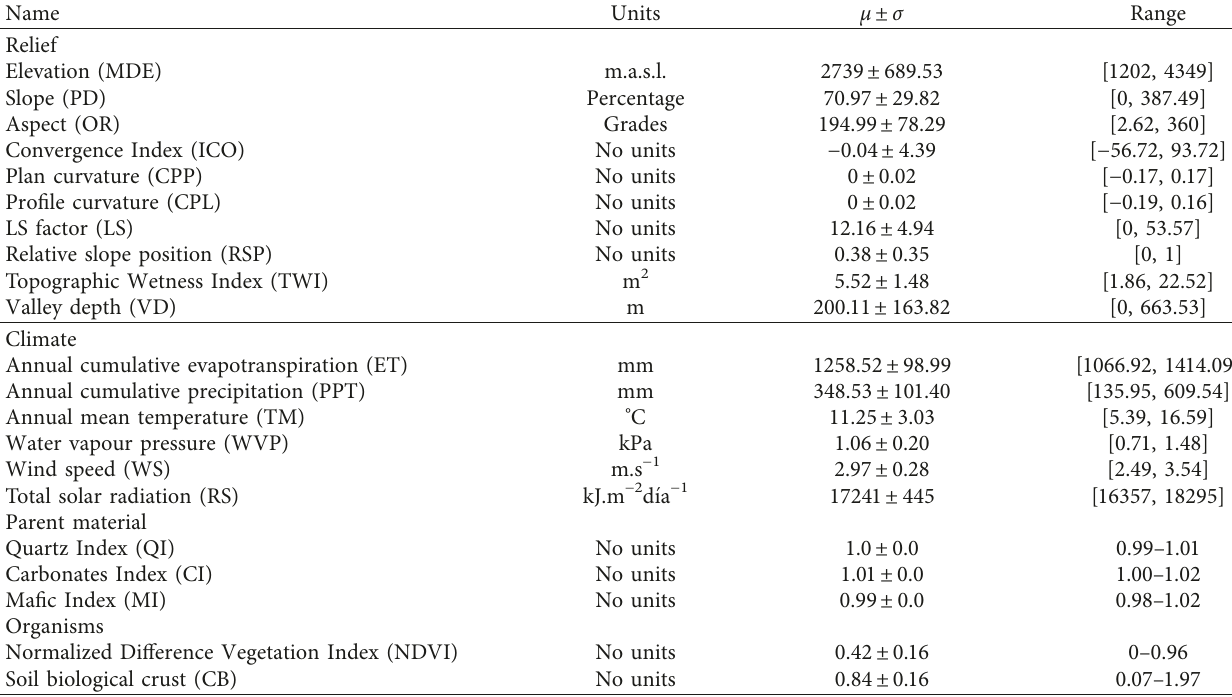
Table 1: Predictor variables description by soil-forming factor. Mean ( µ ) plus standard deviation ( σ ) and range (minimum, maximum) are